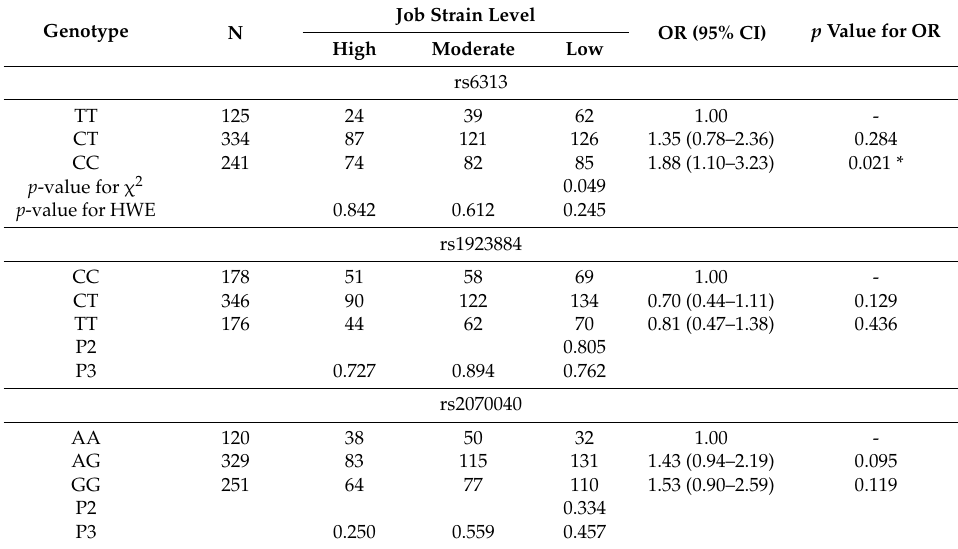
Table 5. Association between 5-HTR2A polymorphism and job